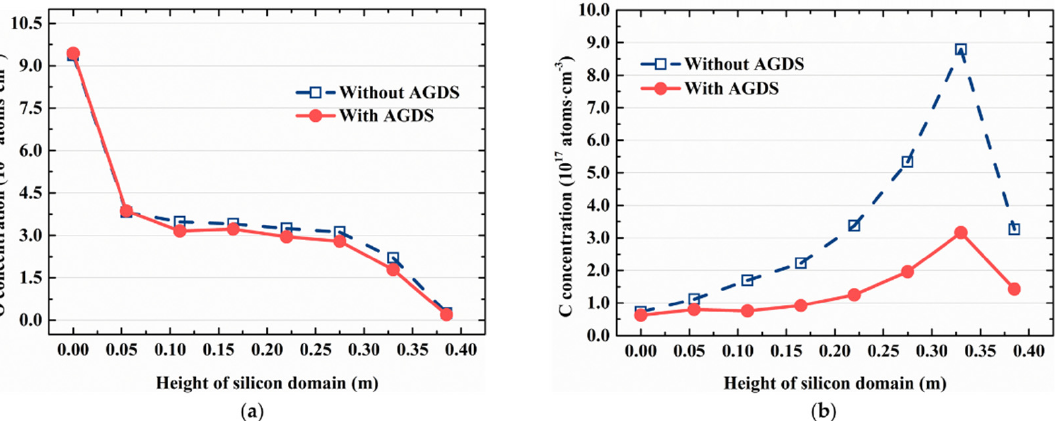
Figure 13. The radial average O ( a ) and C ( b ) concentrations along the height of silicon ingot at 100% crystallization.